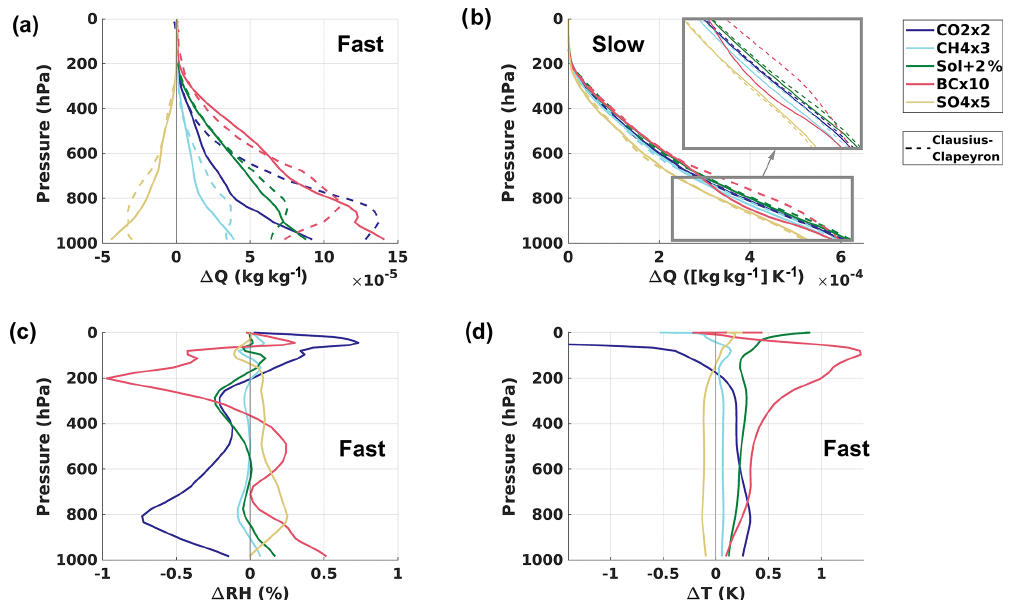
Figure 2. Vertical profile changes for individual drivers. (a) Fast and (b) slow changes in specific humidity ( (cid:49)Q ), and fast changes in (c) relative humidity ( (cid:49) RH) and (d) temperature ( (cid:49)T ), using the mean of the PDRMIP results. In (a, b) , dashed lines show expected specific humidity changes from the Clausius–Clapeyron relation assuming constant relative humidity (calculated for each model, month, and grid box, and with values at pressures < 10hPa set to zero because this approximation does not hold for low pressures). The slow response in (b) is divided by (cid:49)T s induced by each driver, and the inset plot is zoomed in on